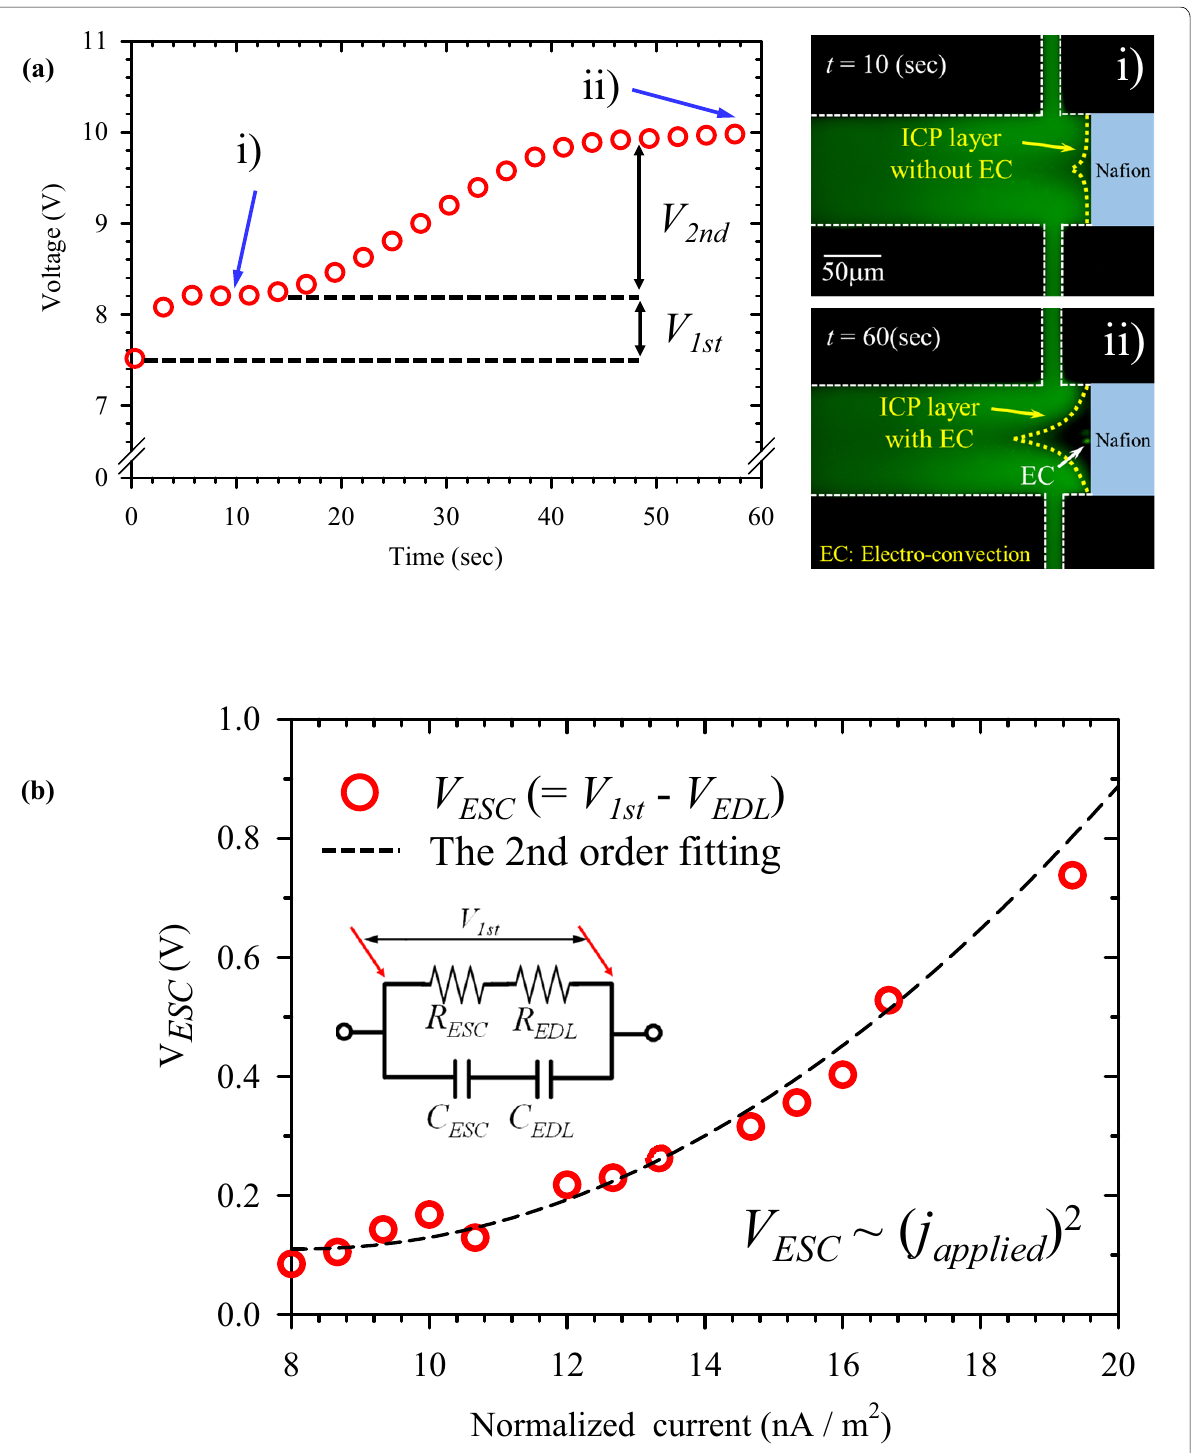
Fig. 3 a The result of chronopotentiometric measurement at 29 nA (in the regime of OLC regime) and the corresponding images at i) t ii) t 60 s, respectively. b The V 1st - i applied relations and the equivalent circuit model of the ICP layer at inset of the =